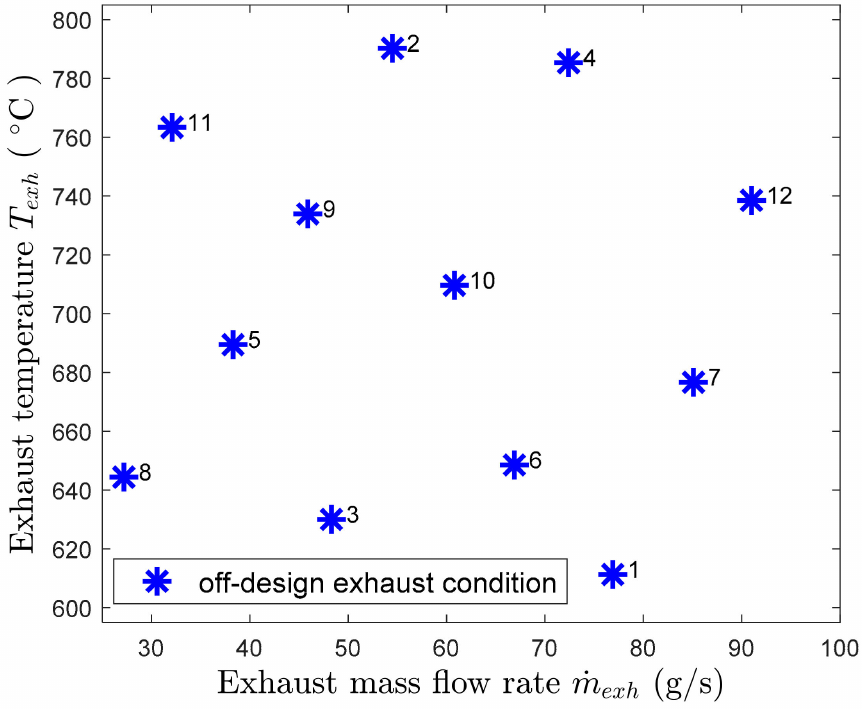
Figure 6. The off-design exhaust